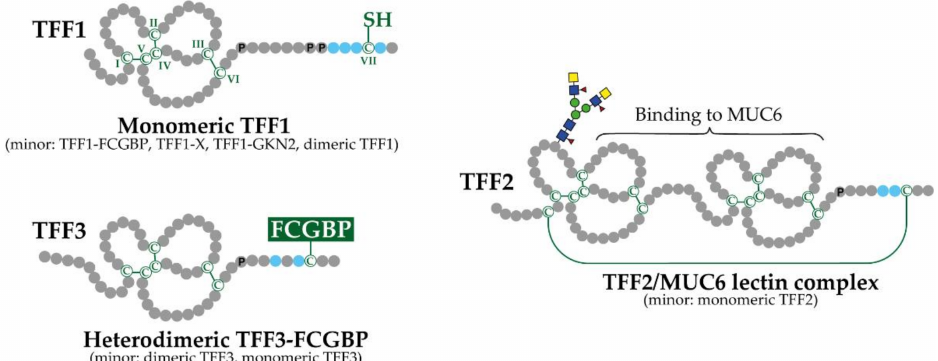
Figure 1. Schematic structures of human TFF1, TFF2, and TFF3 and their major natural forms (minor forms are mentioned in parentheses). Cysteine residues (C; numbering in Roman numerals) and disulfide bridges are shown in green. Proline residues (P) at the C-terminal outside the TFF domains are indicated. Acidic residues in proximity to the C-terminal cysteine residues are shown in blue. Additionally, the N-linked carbohydrate moiety in gastric TFF2 is